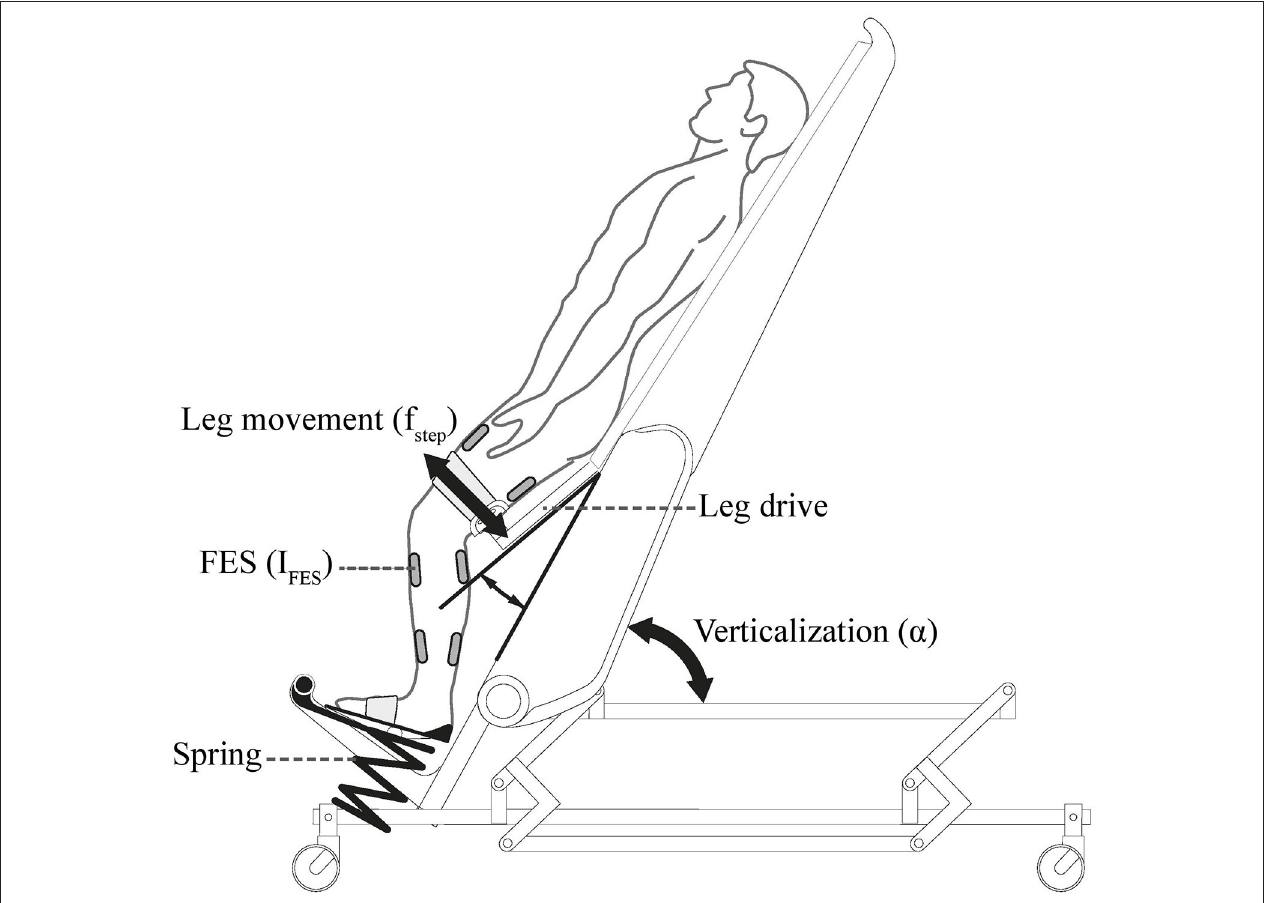
FIGURE 1 | Erigo tilt table: verticalization is provided by changing the inclination angle of the tilt table α . Passive Robotic leg exercise is provided through a leg drive with an adjustable speed f step . The table is further enhanced with electrical stimulation module which enables providing electrical stimulation to the leg muscles with adjustable parameters (here current I FES ) during robotic leg exercise. Picture is copyrighted by Hocoma AG, Switzerland, and is adapted with